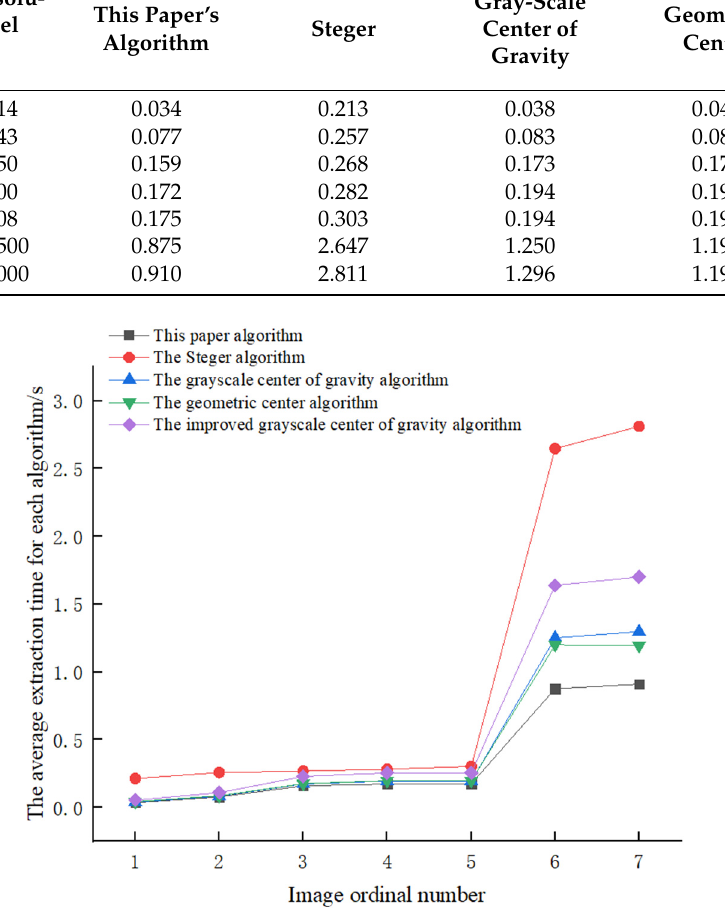
Figure 14. Dashed plot of the algorithms’ average extraction time.